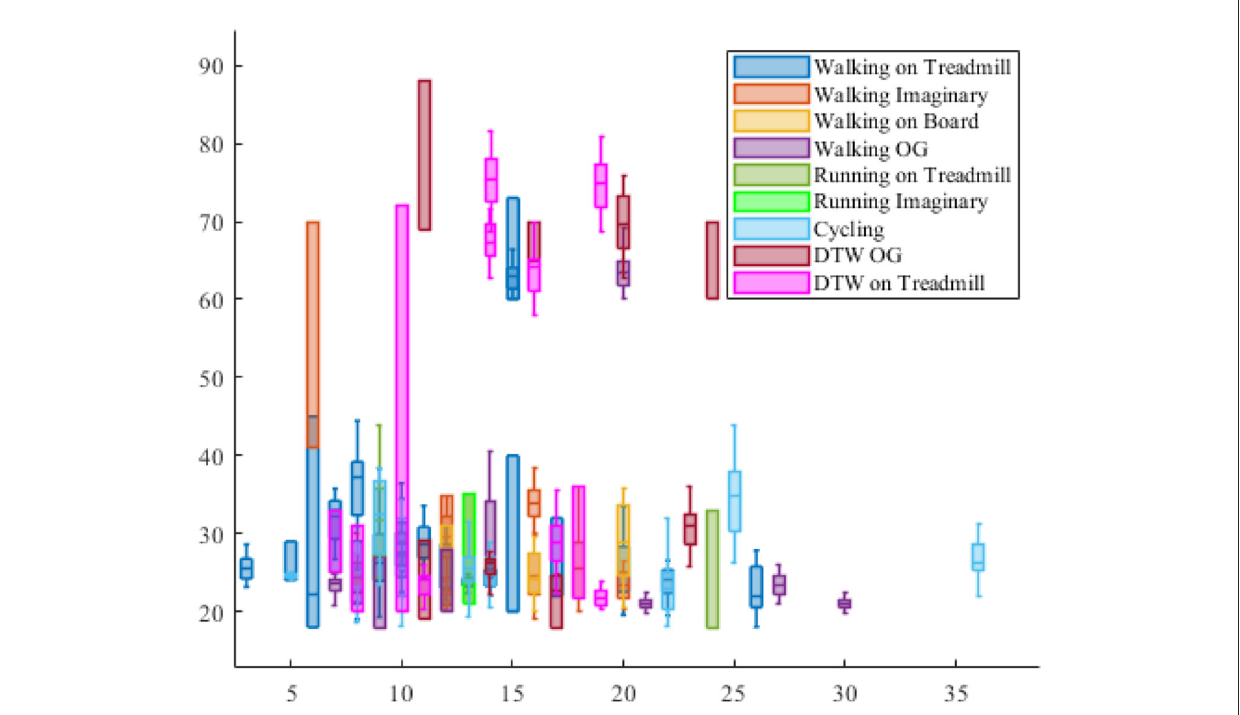
FIGURE6 The participants’ age distribution in each locomotion experiment. The vertical axis shows the age of the participants and the horizontal axis shows the number of participant in the reported experiment protocol.